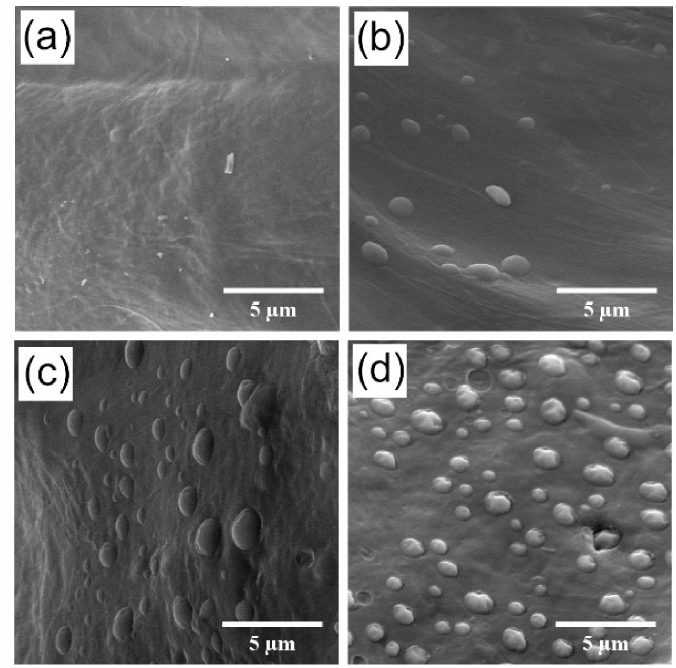
Figure 5. Representative SEM visualizations of prepared Coll/Chit scaffold enriched by increasing concentration of FGF2 with SEM magnification of 10k × : ( a ) pure Coll/Chit; ( b ) Coll/Chit_0.1 FGF2; ( c ) Coll/Chit_1 FGF2; ( d ) Coll/Chit_10 FGF2.